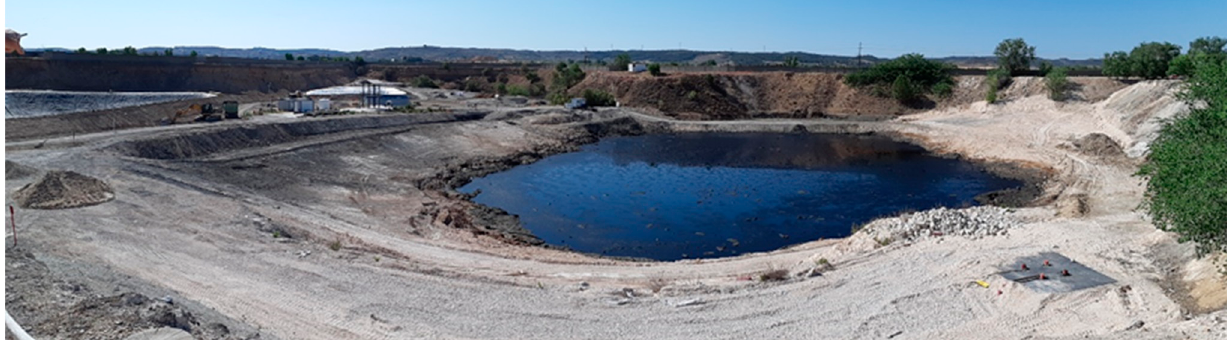
Figure 3. Current situation at Arganda Lagoon.